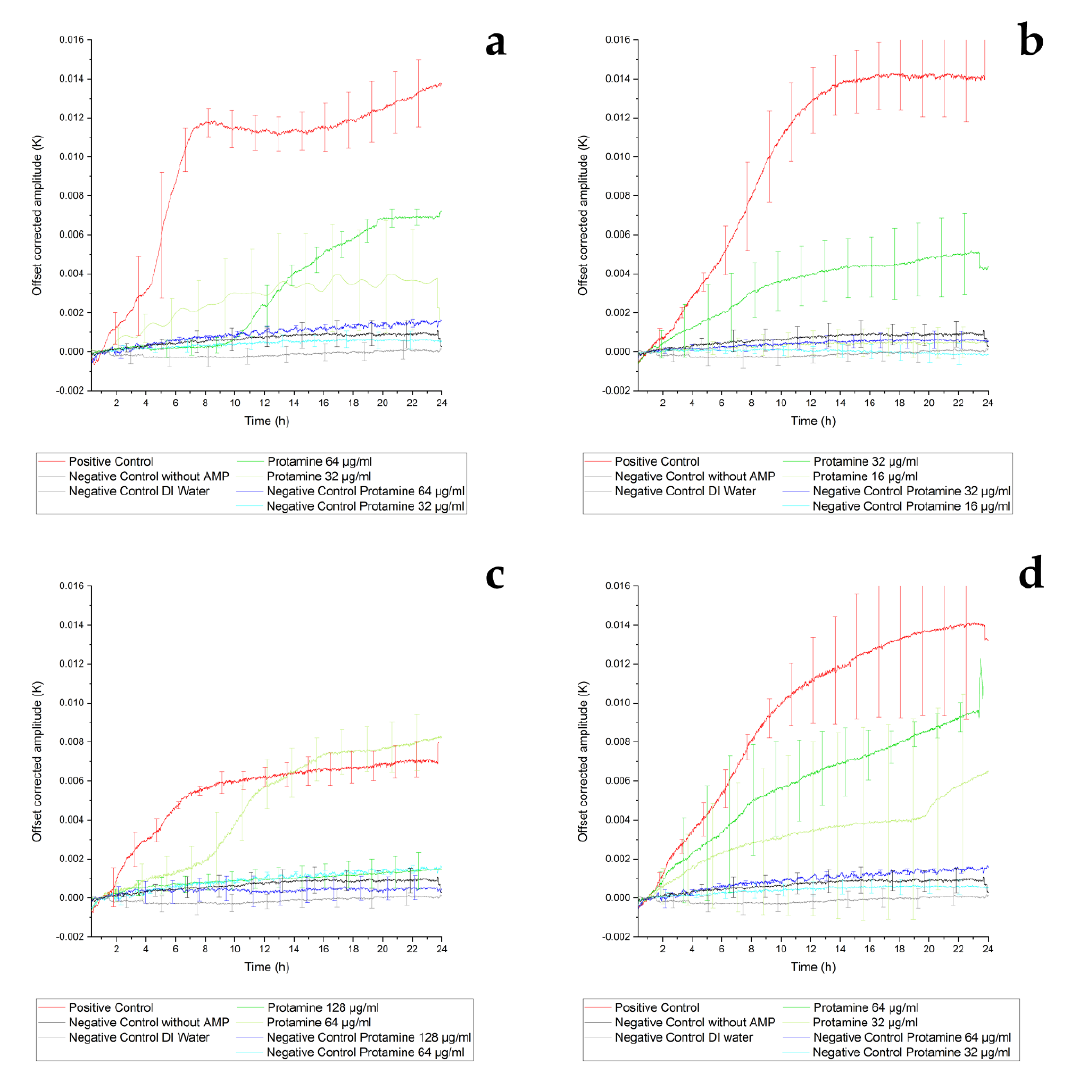
Figure 6. Representation of the thermal sensor measurement (at least n = 3). Different bacterial strains were incubated for 24 h at 37 ◦ C in a thermal sensor setup. The amplitude was measured every second and filtered by a low-pass filter integrated in a lock-in amplifier. The offset was corrected by setting the zero point at 1 h. For clarity, the error bars were staggered. The displayed results were averaged from at least three experiments and the standard deviation is shown as well. The used strains were E. coli ATCC25922 ( a ) and IMT37453 ( c ) as well as S. aureus ATCC29213 ( b ) and IMT37556 ( d ). The strains were incubated in Mueller–Hinton-1 (MH1) medium, either pure medium for positive control (red), with a high or a low dose of the AMP protamine (both green). The negative controls (purple and blue) were also conducted with either dose to exclude the effect of AMP precipitation, as well as pure MH1 medium (black) and deionized (DI) water (gray) to exclude the effect of precipitation of